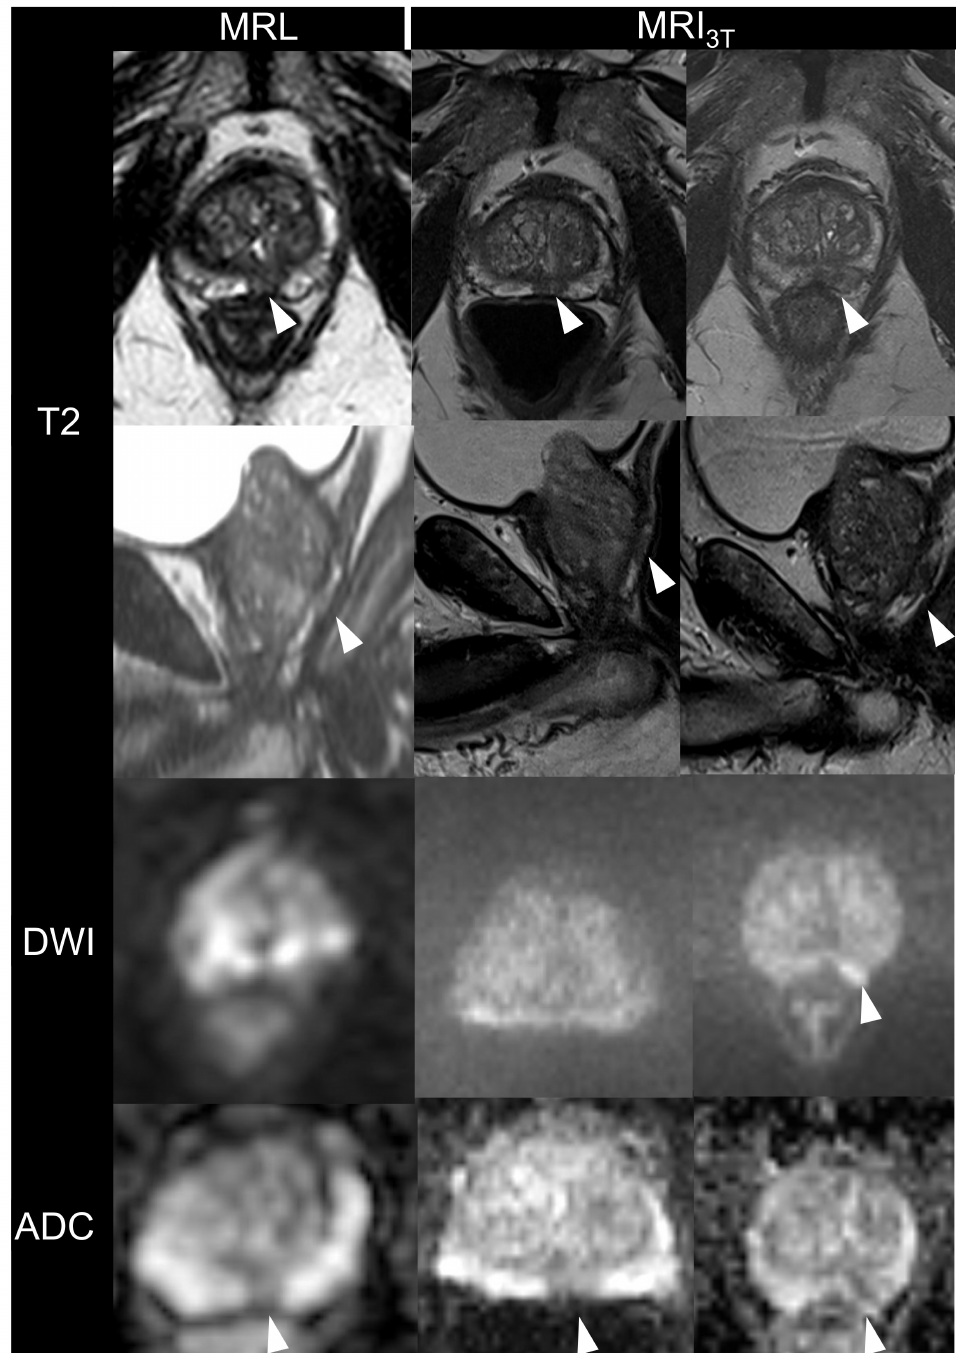
Figure 2. 73-year-old man with an initial prostate-specific antigen level of 7.30 ng/mL and biopScheme 2. weighted images, diffusion-weighted images (DWI) and apparent diffusion coefficient (ADC) maps acquired by the MR-Linac (MRL) at 1.5 T and corresponding images from standard MRI at 3T (MRI 3T ). The left and middle column show MRL and MRI 3T images after 3 months of androgenic suppression therapy. The right column illustrates MRI 3T images before initiation of androgenic suppression therapy. Note that the lesion in the DWI before initiation of hormone therapy is slightly hyper-intense (arrow), whereas after hormonal therapy, the lesion appears rather iso-intense on DWI. Note the hypo-intense region in the apical posterior-medial aspect of the left peripheral zone (arrows). Again, images generated with the MRI3T have better overall image quality when compared to MRL especially in the DWI. Histology of specimen yielded stage cT2c